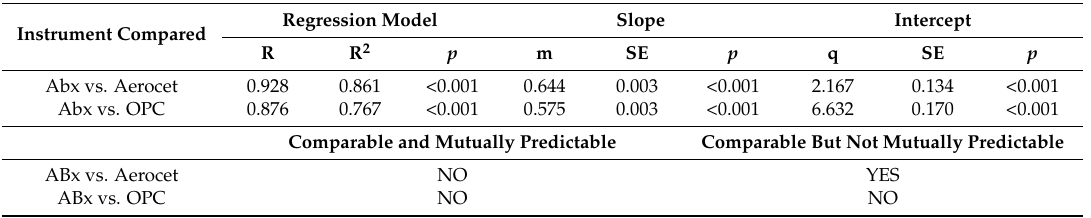
Table 9. Regression parameters between direct-reading instruments (1-min averaged data). N: number of data; R: Pearson correlation coefficient; p : significance; m: slope; q: intercept; SE: standard error. Instrument